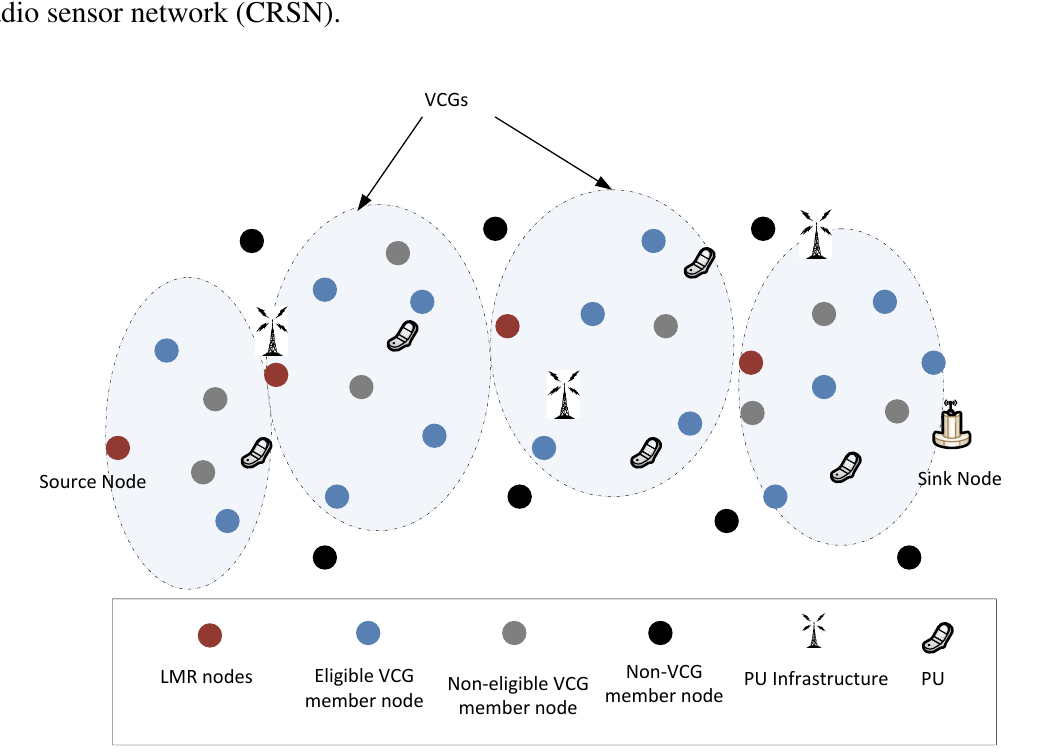
Figure 5. Full network illustration for a reliable opportunistic routing (ROR)-based cognitive radio sensor network